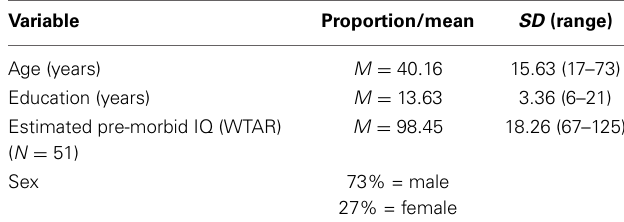
Table 1 | Injury and demographic characteristics of TBI sample ( N =